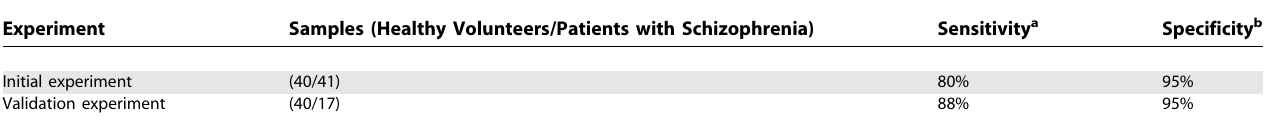
Table 3. Sensitivity and Specificity of PLS Models Calculated from the Two Independent Experiments